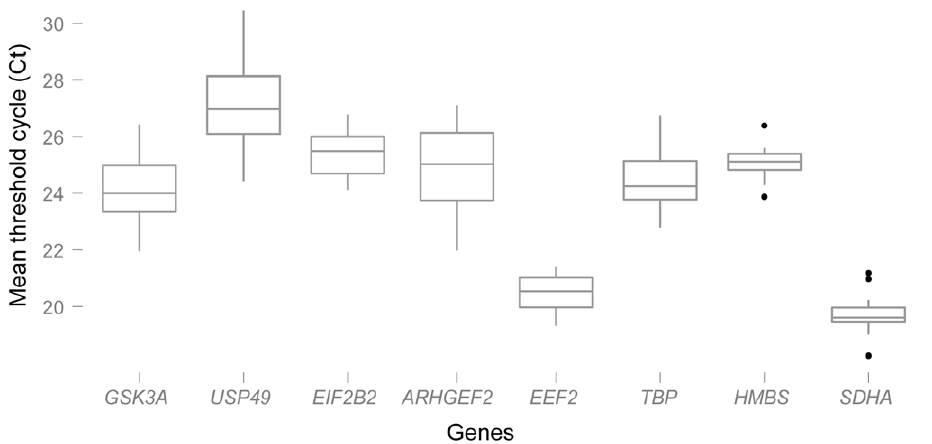
Figure 1. Variation of threshold cycle levels. Box plot of threshold cycle levels of candidate genes for human-chimpanzee samples across combined tissues: skeletal muscle, liver, and cerebral cortex.